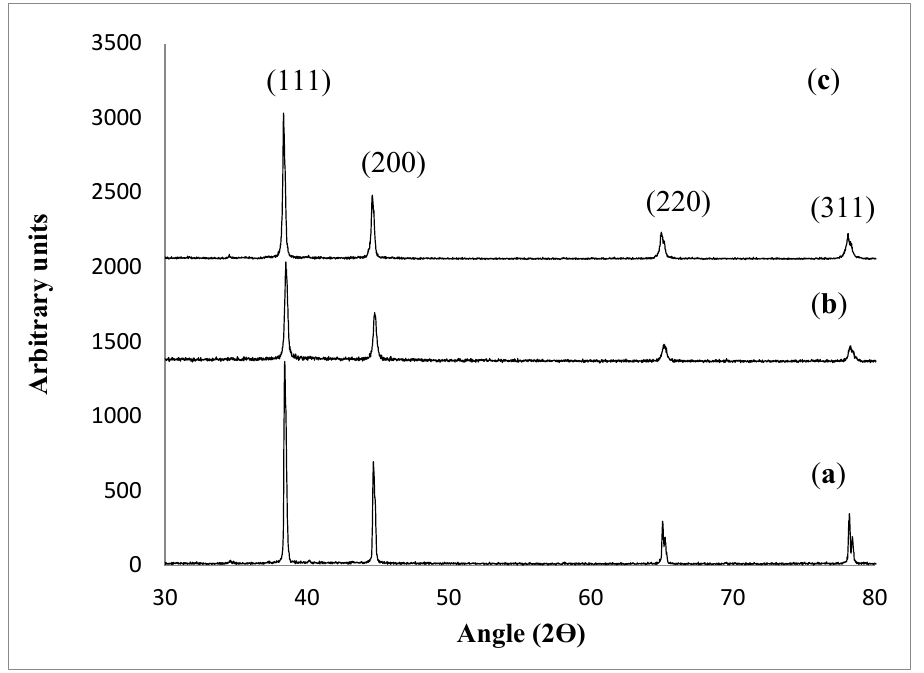
Figure 2. X-ray diffraction spectra of ( a ) pure Al, Al-1wt% SiC sample ( b ) milled for 24 h and ( c ) sintered at 600 °C for 10 min using a pressure of 50 MPa and heating rate of 200